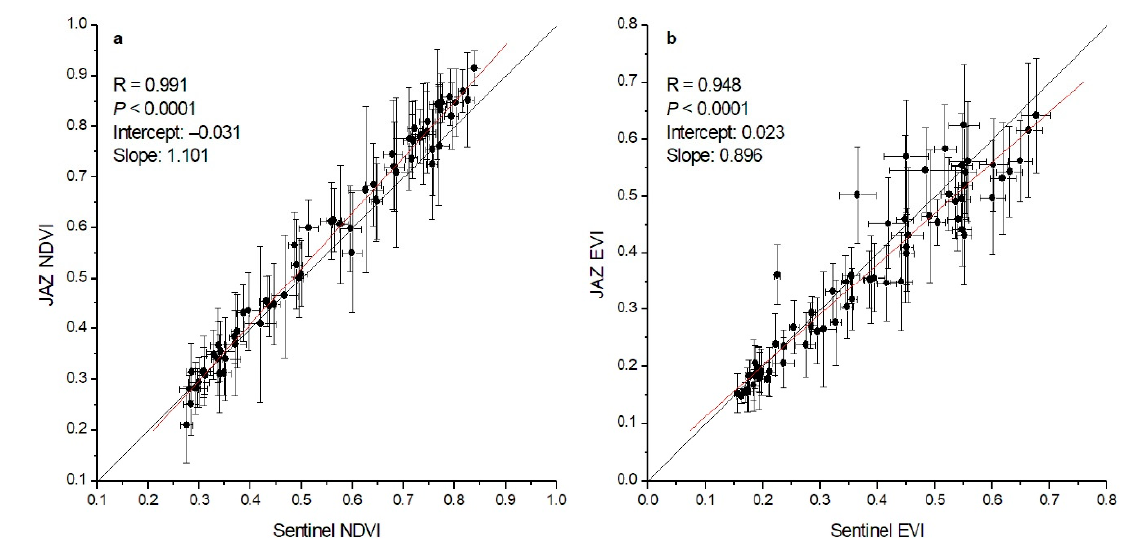
Figure 3. Relationships between JAZ and Sentinel-2 NDVI ( a ) and EVI ( b ). Data concern dates with both Sentinel-2 acquisitions and JAZ measurements. Each point corresponds to the mean from 10 JAZ measurements performed in one plot at one date and the mean from the corresponding 9 Sentinel-2 pixels ± standard deviation.